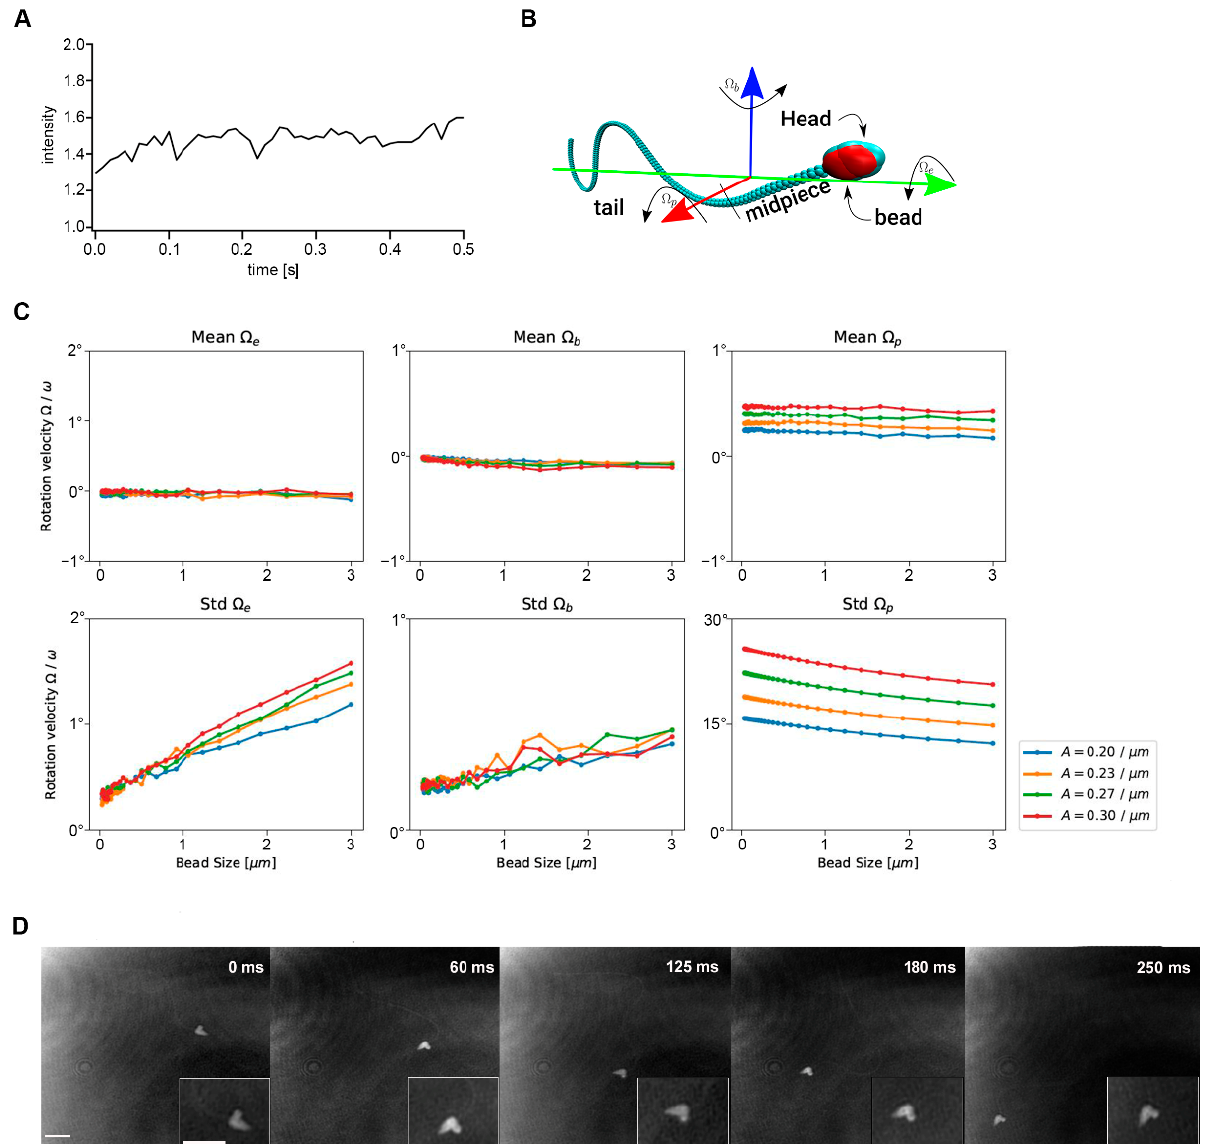
Figure 5. Rolling requires longitudinal stabilizing structures along the flagellum. ( A ) Rolling analysis by measuring the intensity of light scattered from the moving sperm head shows no periodic fluctuations in intensity of reflected light. Based on sea urchin sperm head morphology orientation could not be determined. ( B ) Simulation snapshot of a sperm with an attached bead. Arrows indicate the three main axes of rotation. The different rotation angles ( Ω p , Ω b , Ω e ) are illustrated. ( C ) Simulation results for the main rotation frequencies, as a function of bead size for various beating amplitudes (A = amplitude of the curvature wave). ( D ) XY -projections of a 250 ms holographic record sampled at 198 frames per second (fps) illustrate no rolling of a sea urchin sperm along its long axis by using polystyrene latex beads (0.8 µm mean particle size). Scale bar = 5 µm, N = 3, n = 15.